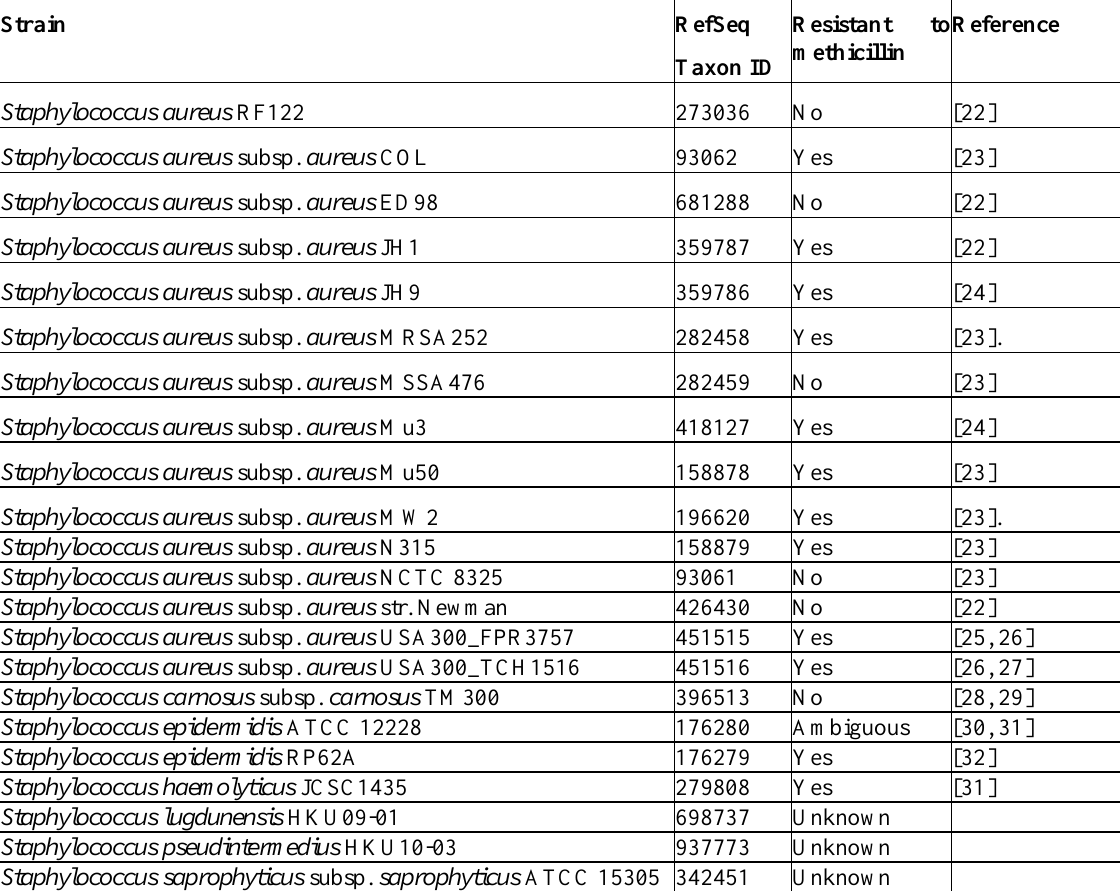
Table 1: A summary of the known methicillin resistance/sensitivity of the Staphylococcal strains whose genomes are available in the NCBI RefSeq database. A value of ‘ambiguous’ in the ‘resistance’ column means that the literature is contradictory; ‘unknown’ indicates that no information about methicillin resistance could be found for a particular strain. Strain RefSeq Resistant to Taxon ID